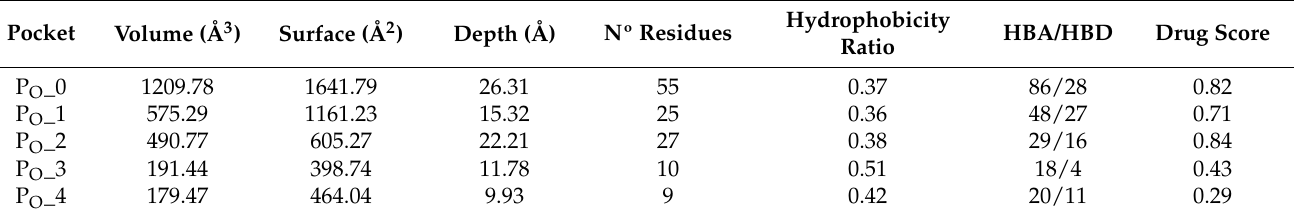
Table 2. The five largest pockets predicted by DoGSiteScorer on the IL-1R1 ectodomain surface (PDB entry 4GAF).